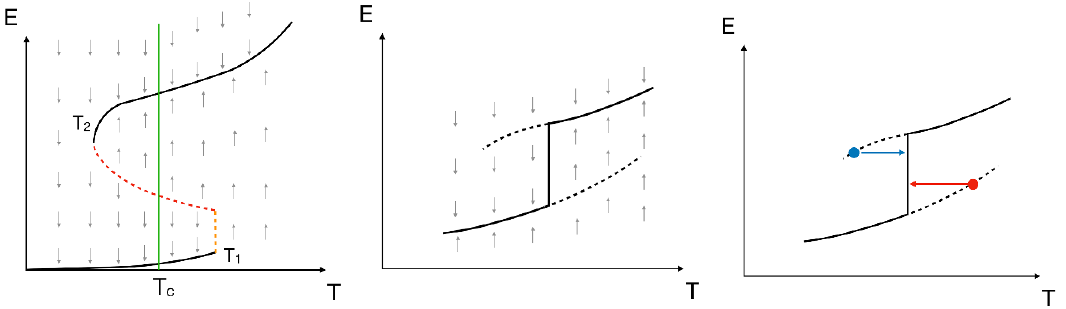
Figure 1 . [Left] The phase structure of 4D N = 4 SYM on S 3 . The orange and red dashed lines denote the Hagedorn string phase and small black hole phase, respectively, which are well-de(cid:12)ned in the microcanonical theory. In the canonical treatment, the small black hole phase is the unstable saddle which is responsible for strong hysteresis. The green line marks the transition temperature in the canonical ensemble, T c . Above T c the large black hole phase is favored, while below T c the graviton gas phase is favored. [Center] A more common example of a (cid:12)rst order transition, for example, between ice and liquid water. Small perturbations can destabilize the metastable states. At the critical temperature, there can be a mixture of two phases, in which ice and liquid water coexist. [Right] Superheated ice (red point) and supercooled liquid water (blue point) are not stable even in the microcanonical ensemble. There is an instability toward the mixture of the ice and liquid